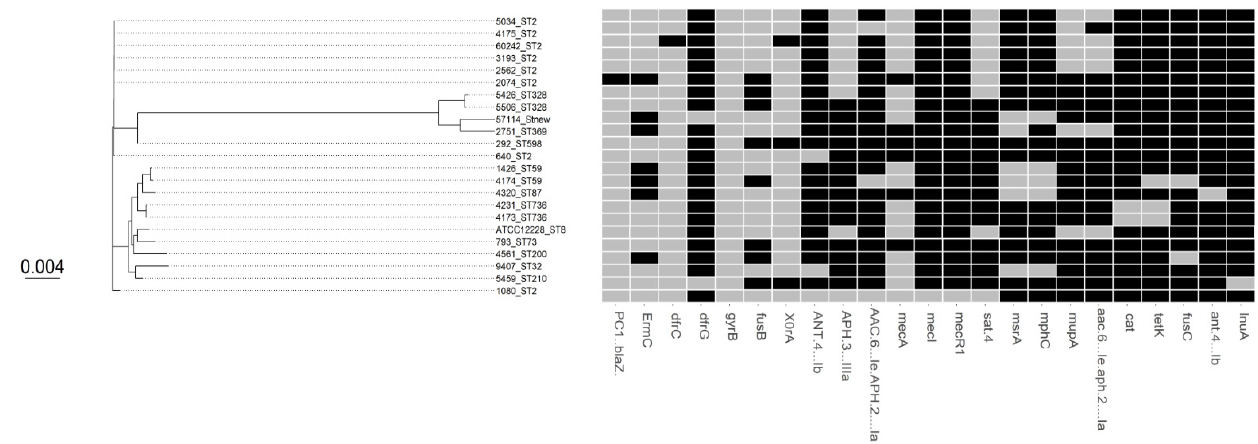
Figure 1. Maximum likelihood phylogenetic tree constructed using core genome alignment from the 24 S. epidermidis clinical isolates. The phylogenetic tree is annotated with the isolate’s sequence type ST. S. epidermidis ATCC 12228 as a reference strain (GenBank accession number: AE015929).